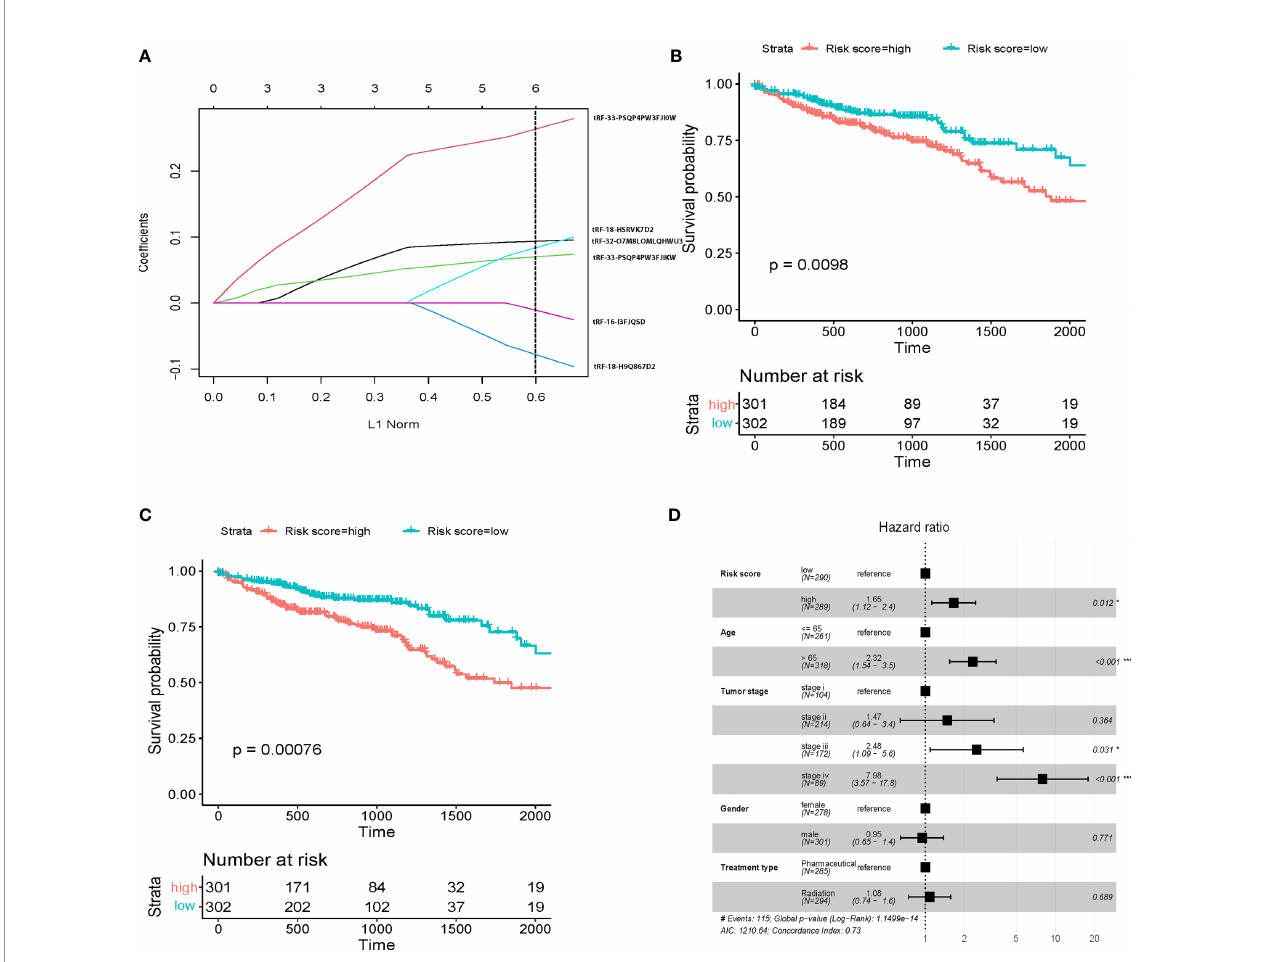
FIGURE 2 | tsRNA prognostic panel. (A) prognostic marker selection: Univariant-Cox and LASSO-Cox were applied to a cohort with survival data to identify seven markers ’ fi nal determination. L1 norm is LASSO coef fi cient pro fi les of the 8 tsRNAs. A vertical line is drawn at the optimal value by 1 s.e. criteria and results in six non-zero coef fi cients. Five tsRNAs were selected in the LASSO Cox regression model. (B) Kaplan-Meier survival curve showing overall survival (OS) in patients without clinical characteristic in high risk and low risk score; (C) Kaplan-Meier survival curve showing overall survival (OS) in patients with clinical characteristic in high risk and low risk score; (D) Multivariate Cox regression analysis of the tsRNA-based prognostic model with OS. Event; *p < 0.05; ***p <